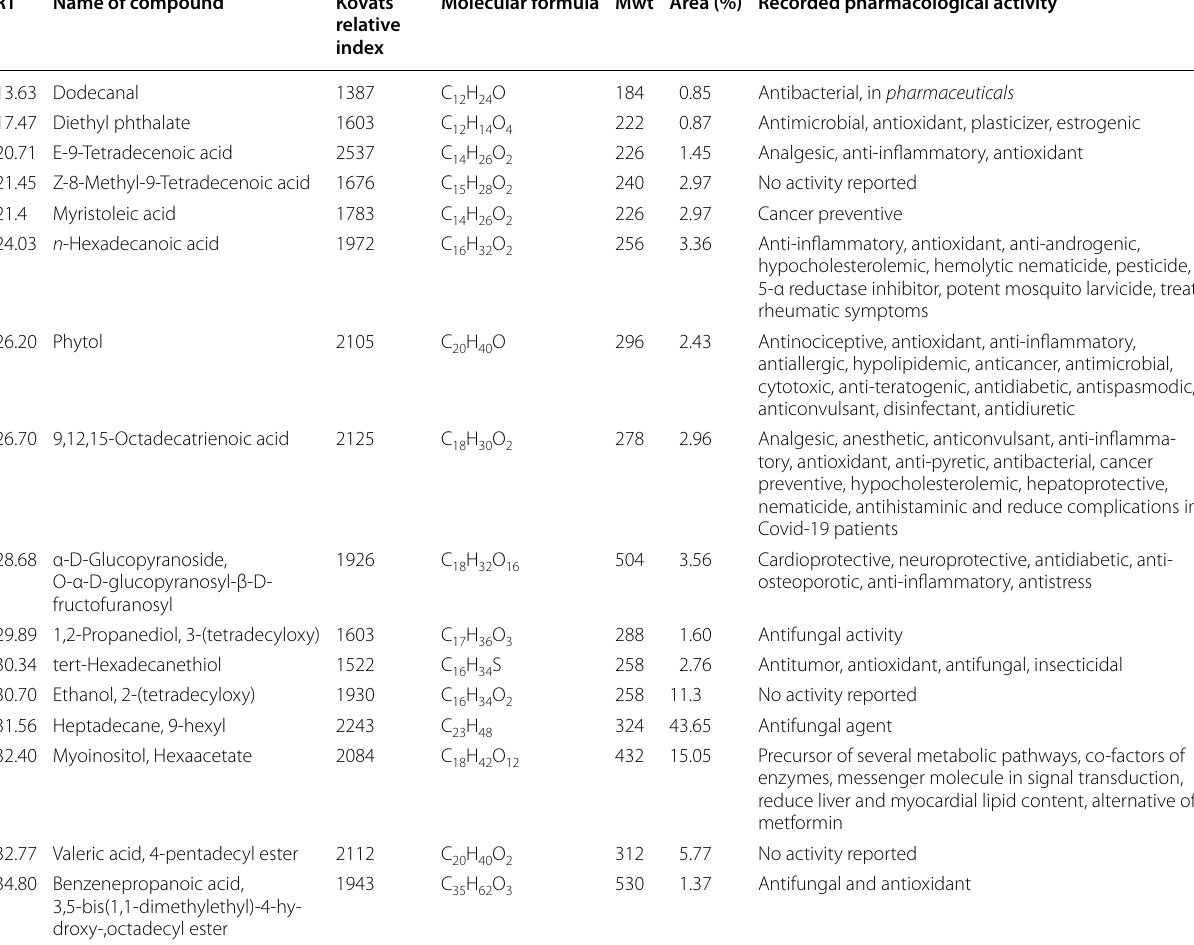
Table 1 Phytochemical constituents identified in leaf methanolic extracts of Solanum khasianum by GC–MS analysis and mass spectra of NIST